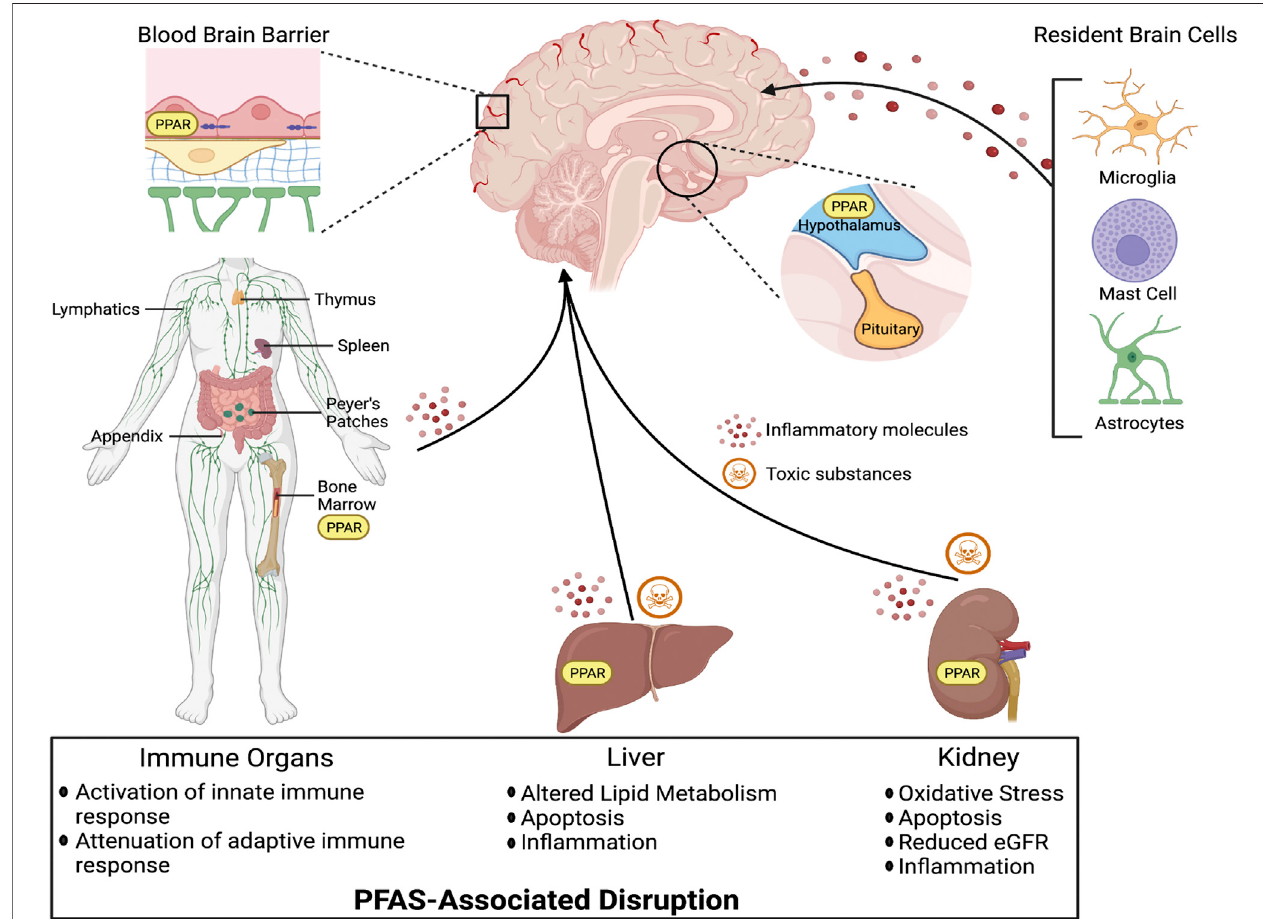
FIGURE 6 | Important indirect mechanisms by which PFAS exposure may impact neurological health include disruption of liver, kidney, and peripheral immune systemfunctions.Buildupoftoxicsubstancesandin fl ammatorymoleculesincirculationhavethepotentialtocompromisetheBBB,damageneurons,andcontributeto neurodegenerative diseases. PFAS have also been identi fi ed as PPAR agonists which are expressed in the liver, kidneys, immune organs, and brain, making PPARs an important molecular target for both direct and indirect effects of PFAS in neurological health.